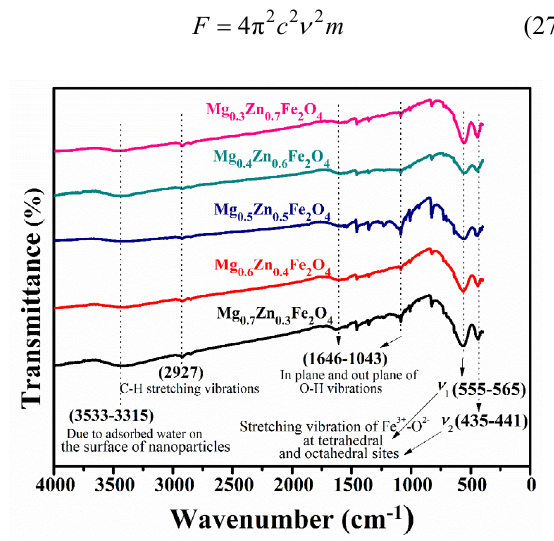
Fig. 3 FTIR spectra of Mg 1– x Zn x Fe 2 O 4 ( x = 0.3, 0.4, 0.5, 0.6, and 0.7) NPs.